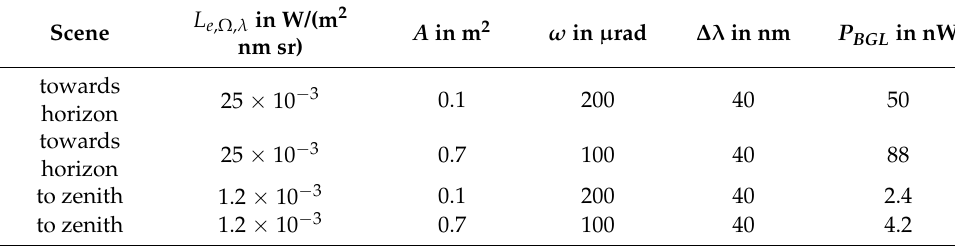
Table 2. Typical values of P BGL for a 1550 nm wavelength. L e , Ω , λ in W/(m 2 Scene A in m nm sr)